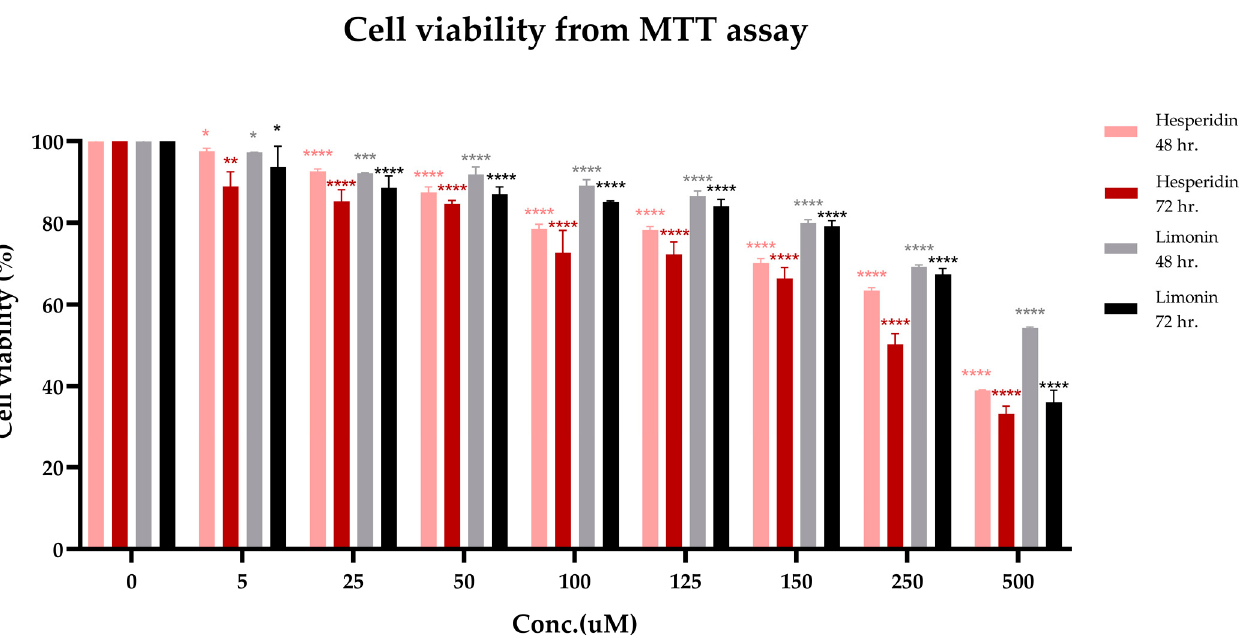
Figure 3. Cell viability (from MTT assay) of PLC/PRF/5 human hepatocellular carcinoma cells treated with hesperidin for 48 h. (pink bars), 72 h. (red bars) and limonin for 48 h. (grey bars), 72 h. (black bars). The statistical differences were separately analyzed for limonin and hesperidin by using one-way ANOVA followed by the Bonferroni comparisons test. The symbol *, **, *** and **** mean p < 0.05, <0.01, <0.001 and <0.0001, respectively, compared with the negative control (0.5% DMSO) .